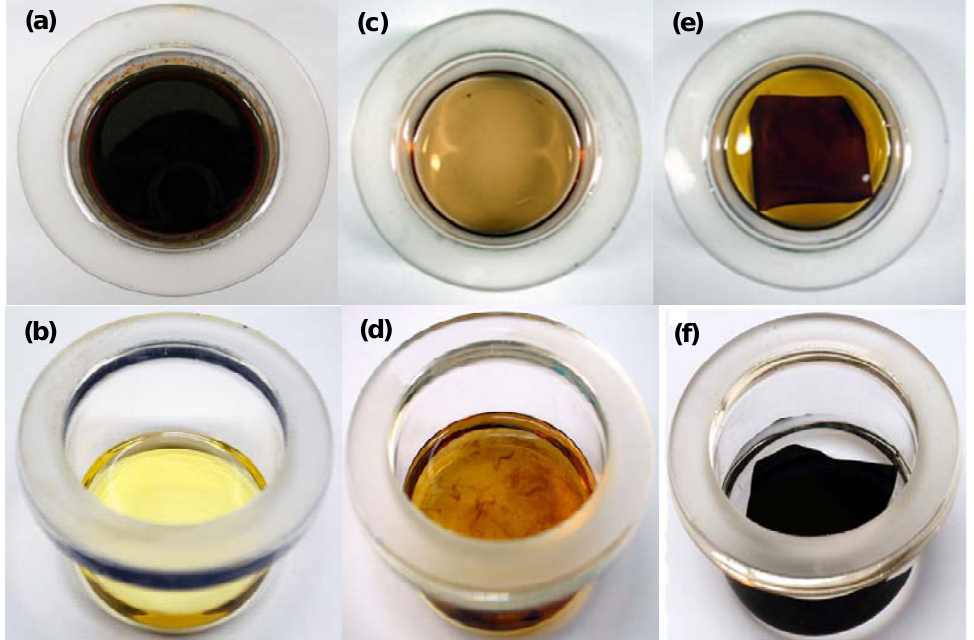
Figure 6. Chemical stability of ( a ) P( p BUa); ( b ) P p F; ( c ) PBI; ( d ) ABPBI; ( e ) P( p BUa- co -BI)-65; and ( f ) P p F- co -ABPBI membranes after being immersed in an 85 wt % PA solution at 160 °C for 1